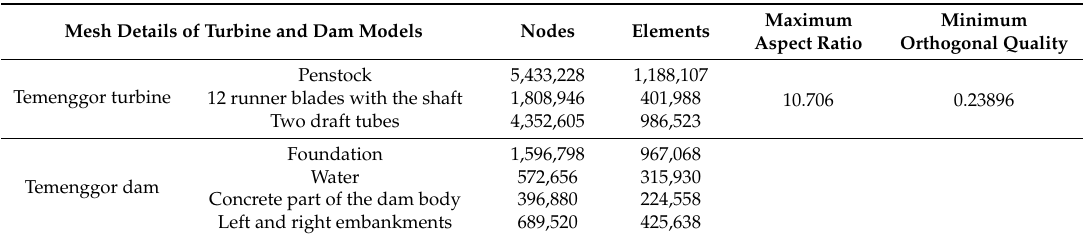
Table 4. The mesh details of the Temenggor Francis turbine and dam